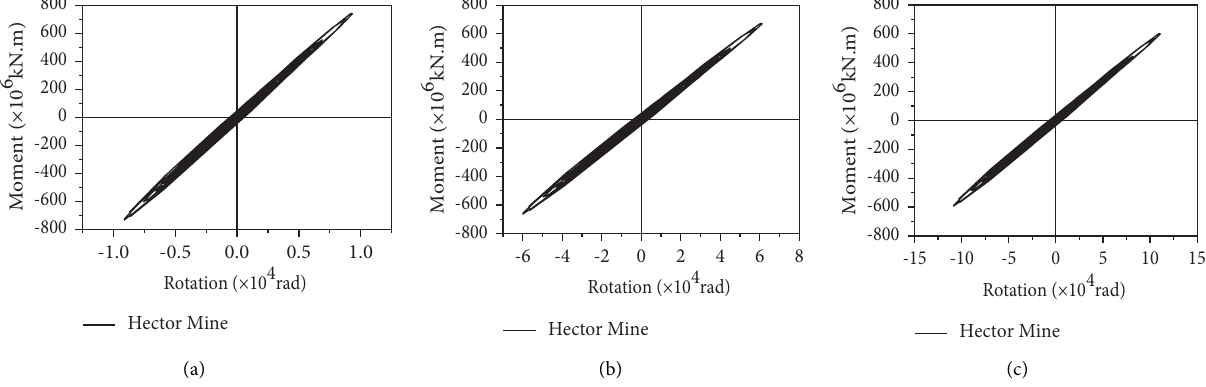
Figure 5: Moment-curvature relationship of pier bottom element under seismic action of Hector Mine earthquake. (a) First element. (b) Second element. (c) Third